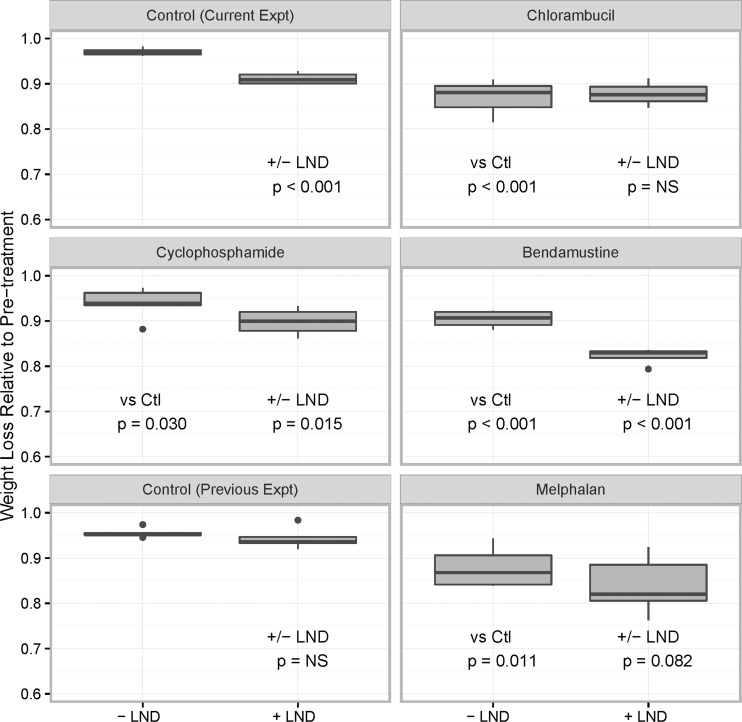
Weight Loss Experiments on DB-1 Melanoma Xenografts.Box plot of weight loss relative to median pretreatment weight for the control and each alkylating agent with (+) or without (-) LND (lonidamine). Bold horizontal lines indicate median, boxes indicate interquartile range, (IQR) whiskers extend to the smaller of either the range of the data or the box +/- 1.5 IQR. Outliers appear as dots. Abbreviations are as follows: Ctl, Control; NS, Not Significant.